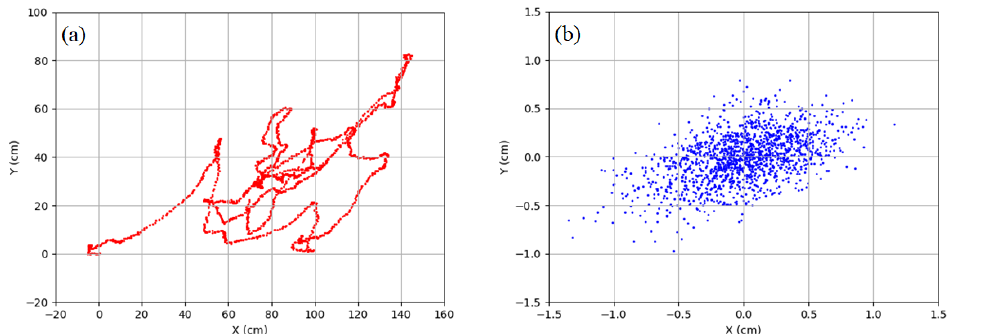
Figure 6. Position drift over time for DJI M600 with ( a ) GNSS and ( b ) RTK-GNSS. The experiment was conducted on 23 February